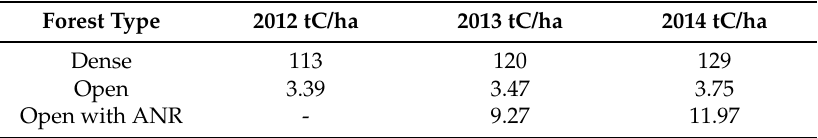
Table 1. Changes in Carbon Stocks by Forest